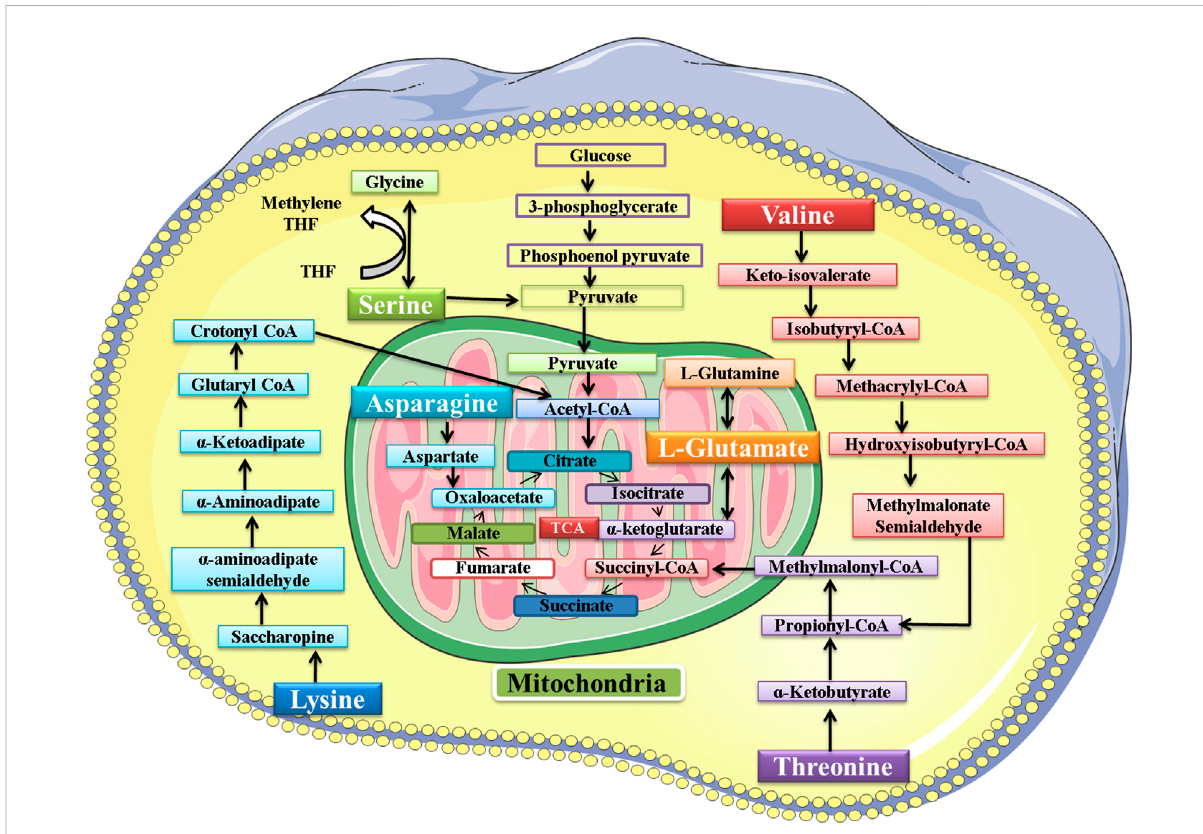
FIGURE 13 Metabolic pathway of valine, serine, threonine, lysine, glutamic acid, and asparagine. After metabolism, the fi nal product of these amino acids enters the tricarboxylic acid (TCA)